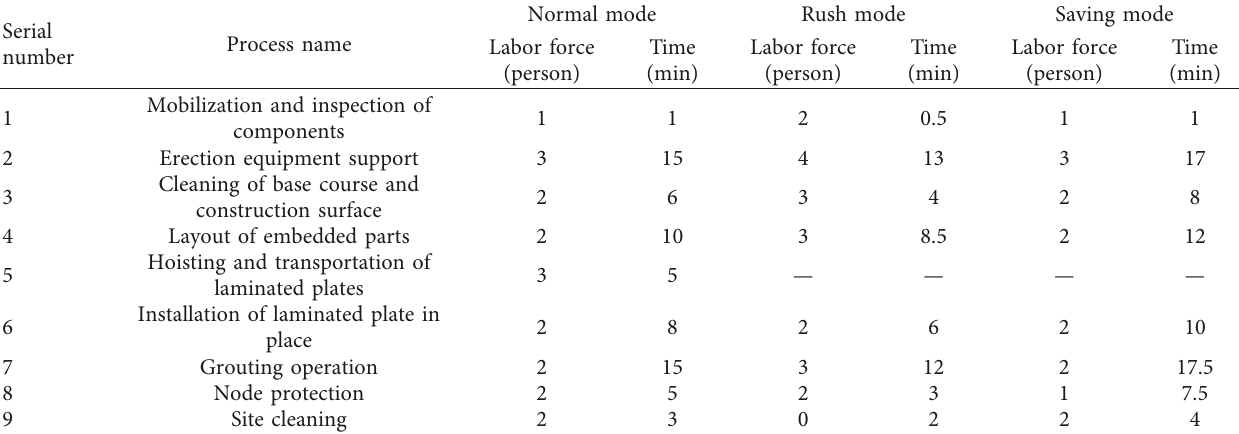
Table 1: Summary of basic information of construction mode in installation process of laminated plate components.